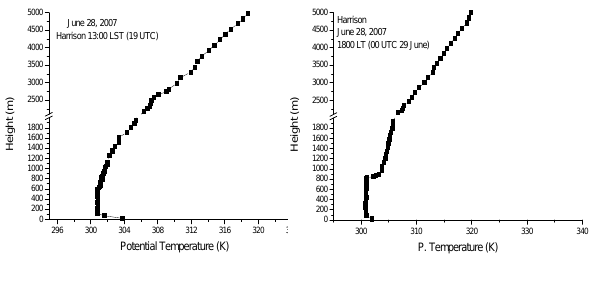
Figure 5 : Vertical profiles of potential temperature at Harrison site on June 28.